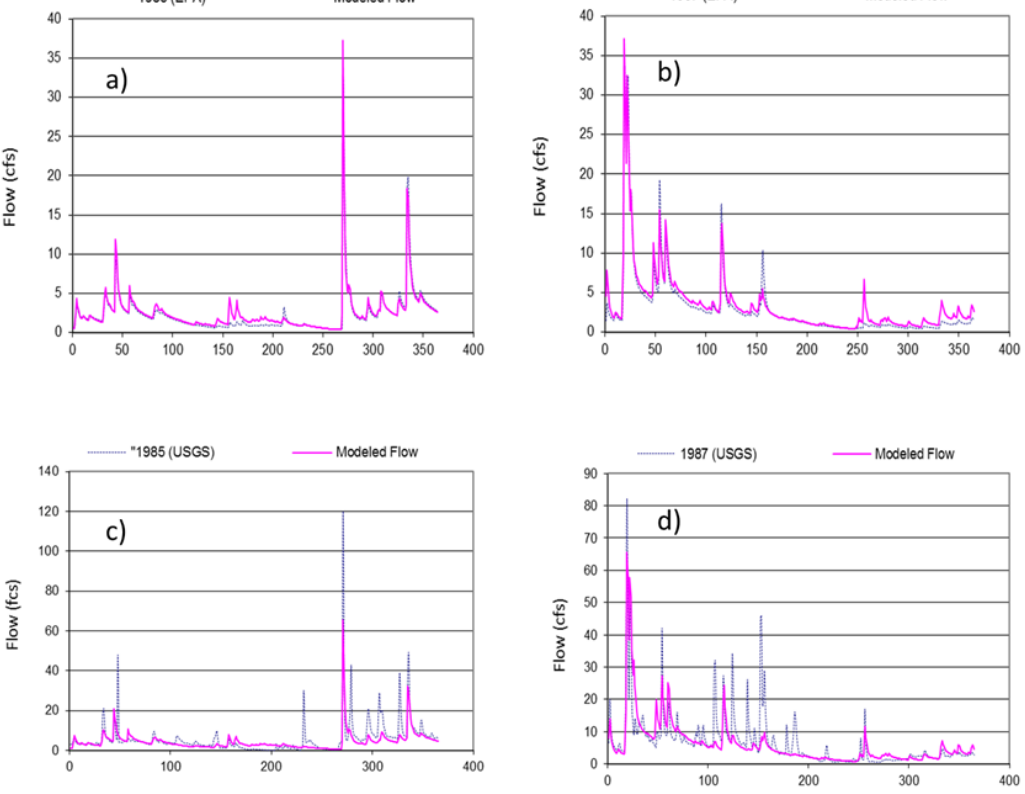
Figure 7. Time Series Comparison of the Daily Stream Flow between Model Simulation and Observed Data from USGS Stream Gage 01670000 in 1985 and 1987 (panels ( a , b ) show unit acreage flow, panels ( c , d ) show comparisons to USGS gage). Table 2. Key parameters used for hydrological simulation.